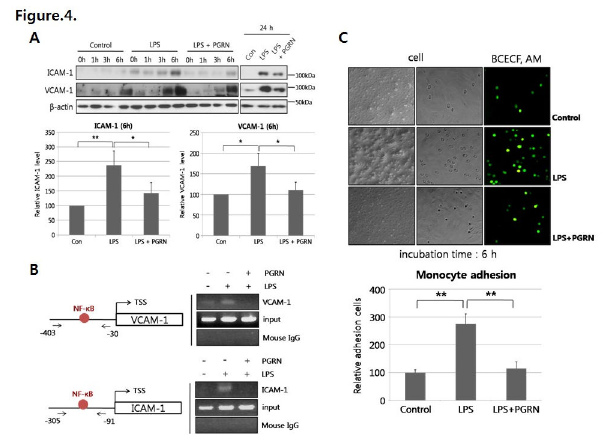
Figure 4. Progranulin (PGRN) blocked monocyte adhesion to through of adhesion